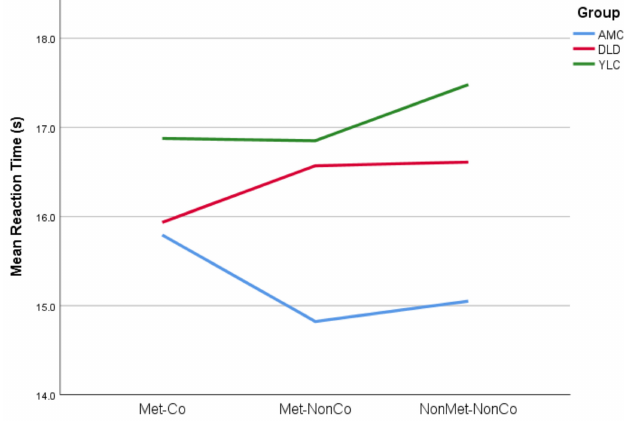
Figure 3. A graph of mean reaction times to each condition by